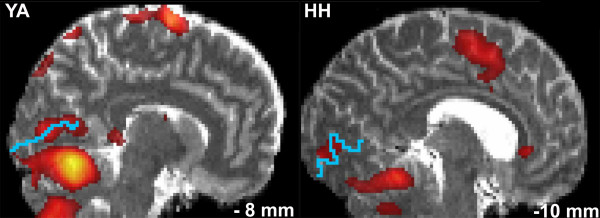
Individual analysis of the task-related activation in the V1. The foci with significant activation during Mah-Jong tactile discrimination by experts (YA, left; HH, right) were superimposed on the parasagittal sections (MNI coordinates of x = -8 mm for YA, and x = -10 mm for HH) of the T2-weighted high-resolution MRI of each subject. Blue lines indicate the calcarine sulcus.